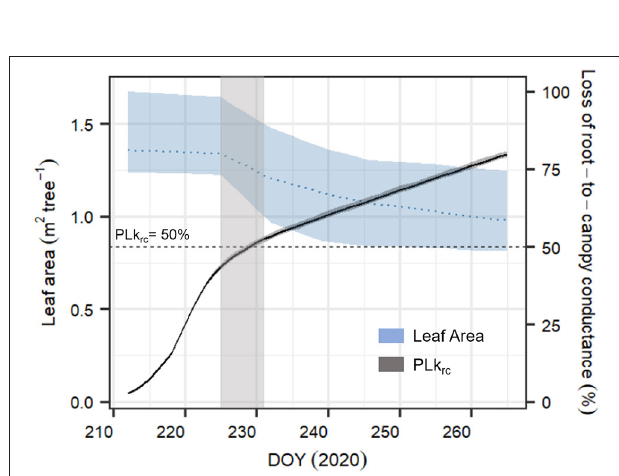
FIGURE 8 | Time series of averaged leaf area (in m 2 tree − 1 , blue dashed line) for the six monitored Pinus sylvestris saplings and simulated dynamics in percent loss in root-to-canopy conductance ( PLk rc , in %, black continuous line) according to the complete SOX + model scheme (Hydraulic + NSL + leaf shedding). Daily leaf area is represented as the mean ± SD. Daily simulated PLk rc is represented as the median ± 95% CI after 500 model simulation runs by sampling the posterior parameter estimate. The horizontal line indicates when k rc = 0.5 * k rc , max ( PLk rc 50 , dashed line), while the light gray area represents the uncertainty of when the leaf shedding rate accelerated. Because of weekly sampling campaigns, the area is relatively broad.